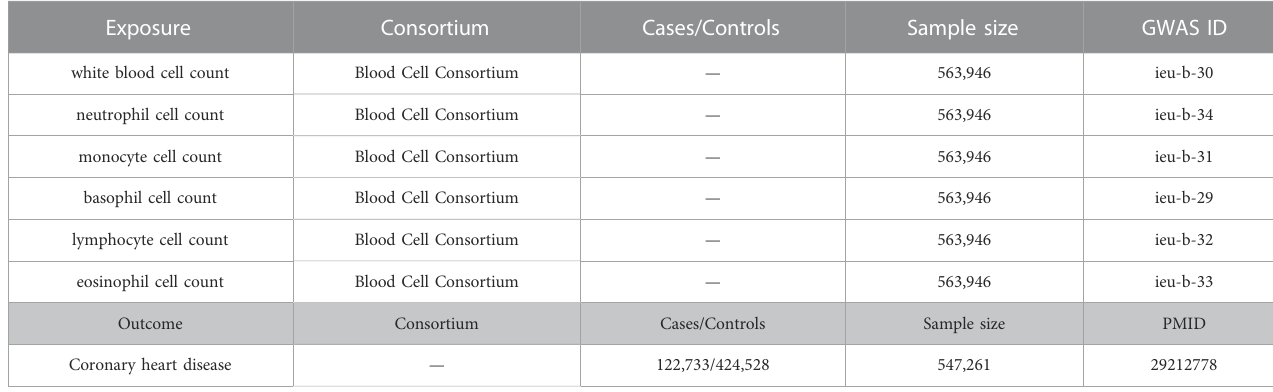
TABLE 1 Characteristics of blood cell counts and coronary heart disease datasets. Exposure Consortium Sample size white blood cell